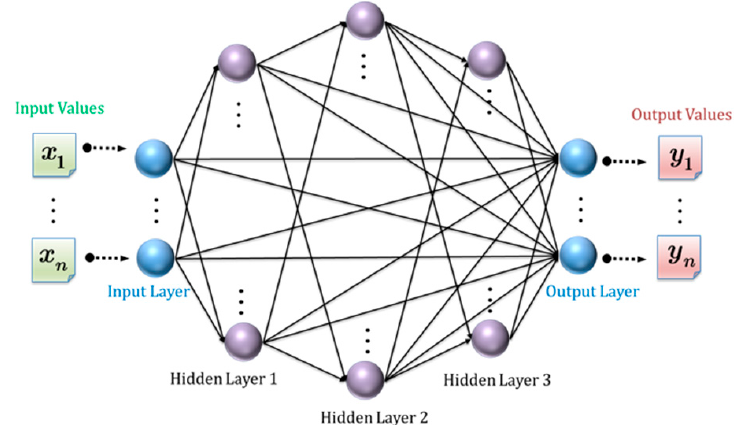
Figure 8. Network structure of a dynamic learning neural network (DLNN). It features every node at an input layer, and all hidden layers fully connected to the output layer; the activation function is removed from each output node, and the output of the modified network can be characterized as the weighted sum of the polynomial basis vectors.